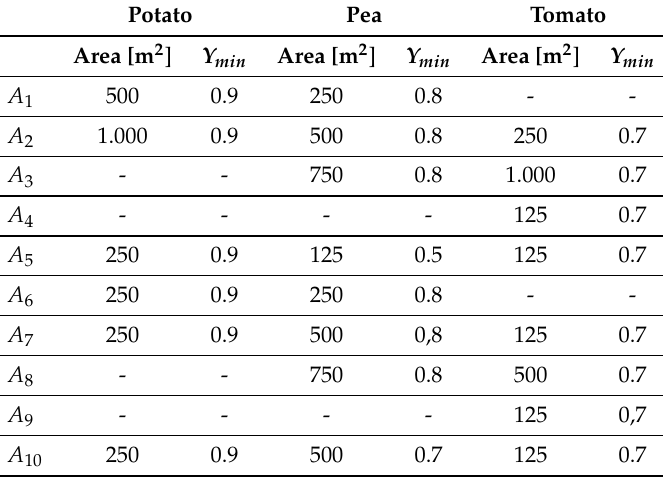
Table 2. Farmer crop